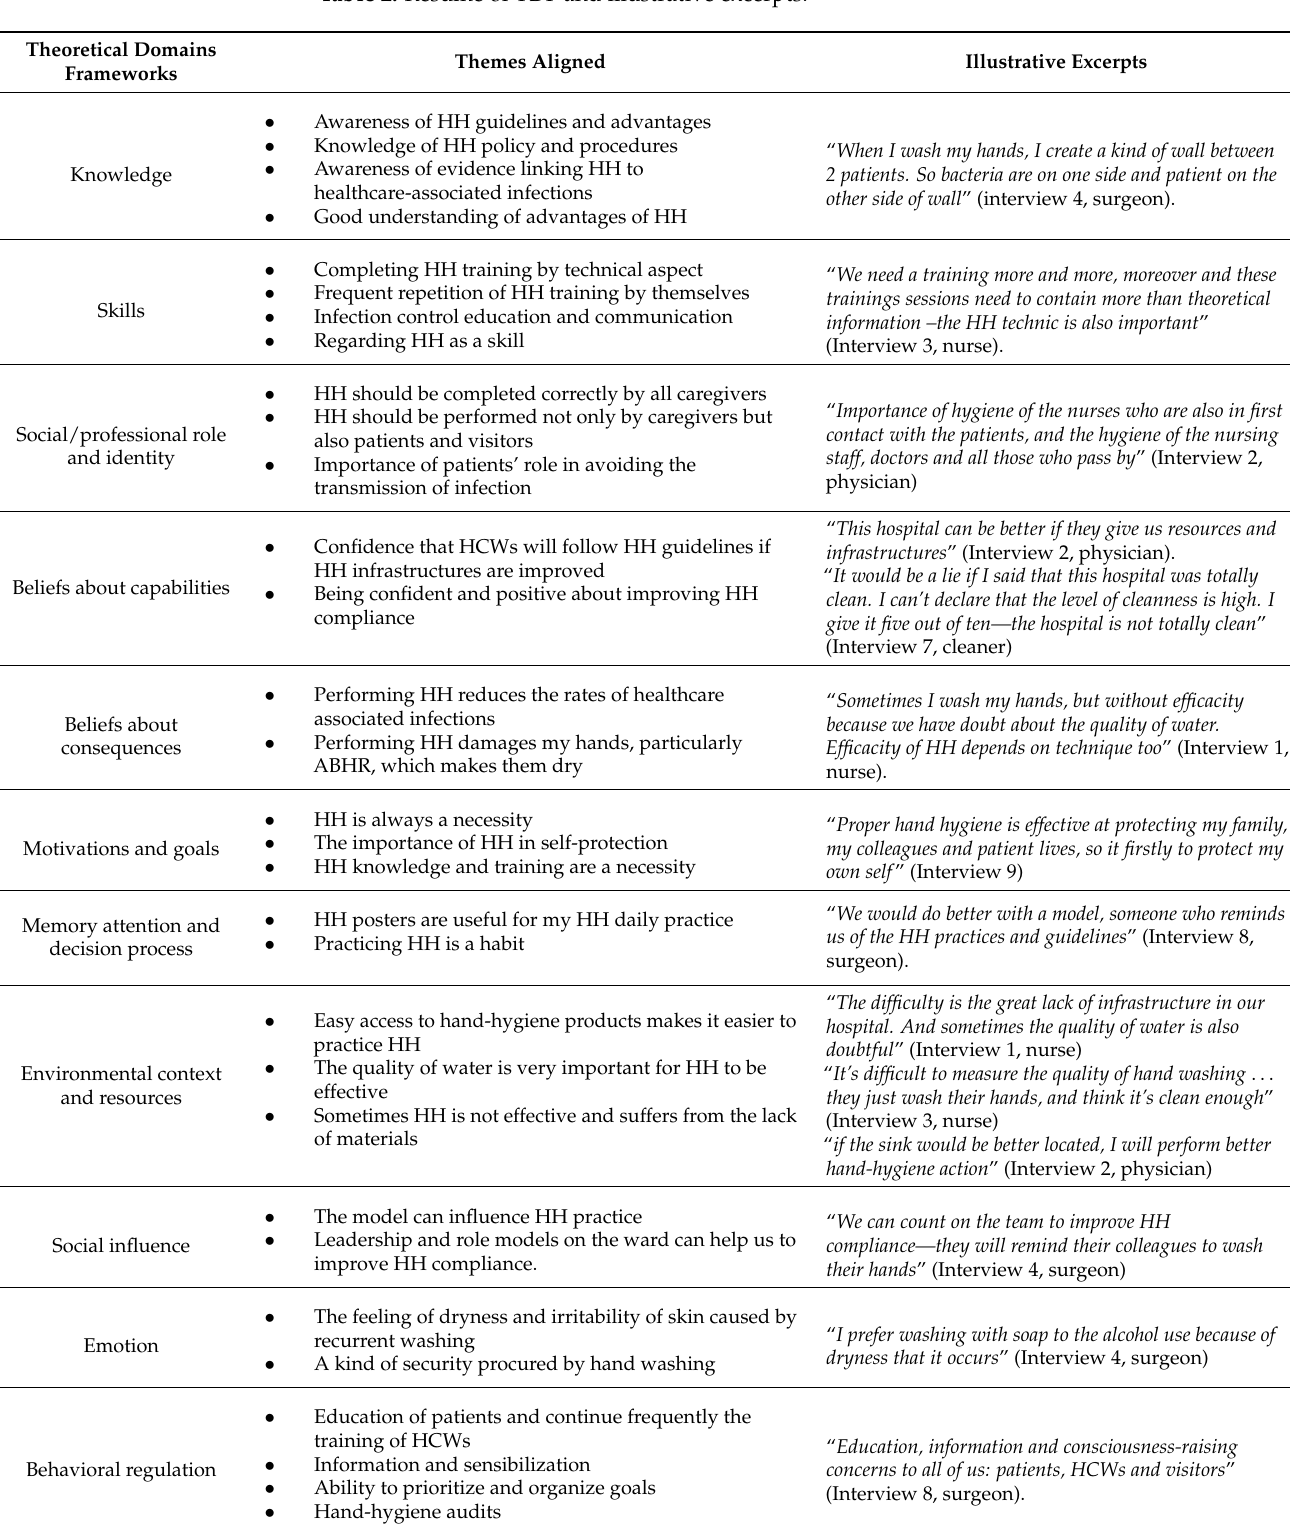
Table 2. Resume of TDF and illustrative